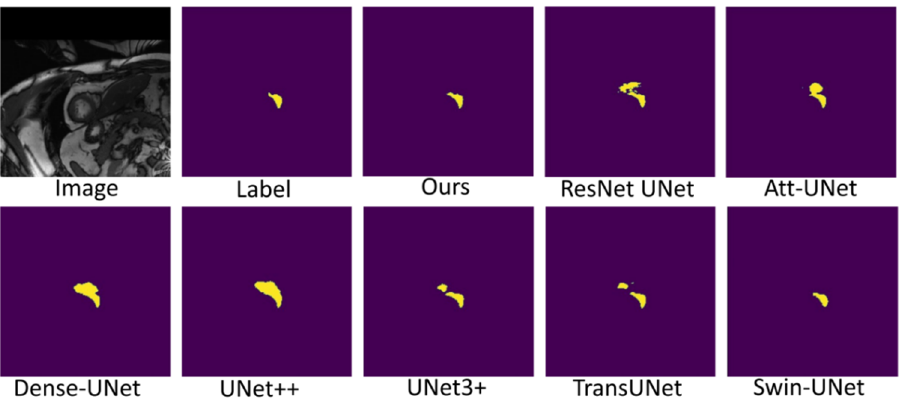
Figure 6. The variation of the training set dice score with iterations.